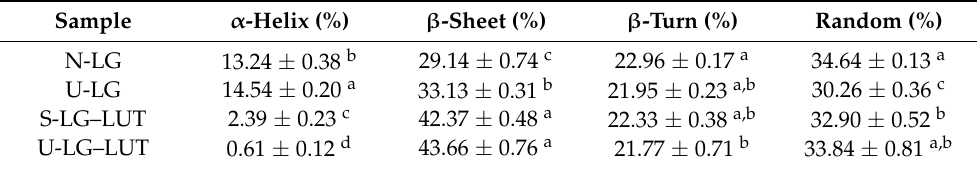
Table 1. Secondary structure of N-LG, U-LG, S-LG – LUT and U-LG – LUT. Letters a – c in the table indicate significant differences ( p < 0.05).